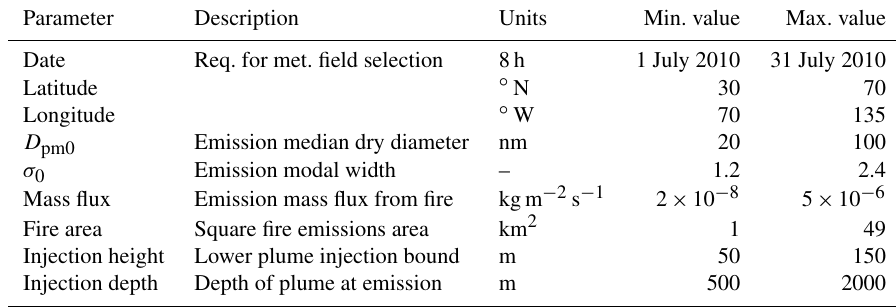
Table 2. Parameter ranges for inputs to the SAM-TOMAS model. Parameter Description Units Min. value Max. value Req. for met. field selection